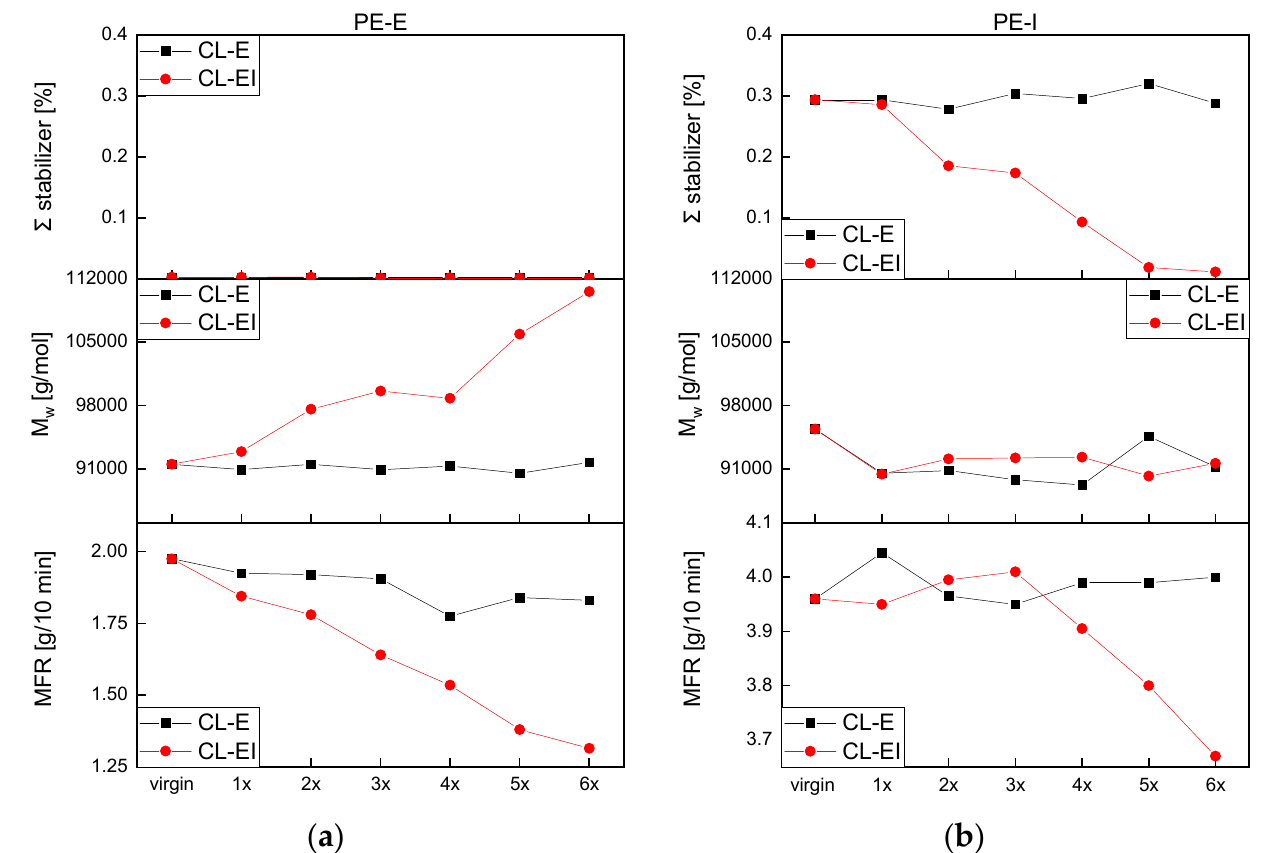
Figure 10. The sum of antioxidants (IF168 and IX1010), the weight average molar mass (M w ), and the melt flow rate (MFR) as a function of recycling steps for ( a ) PE-E, and ( b ) PE-I.